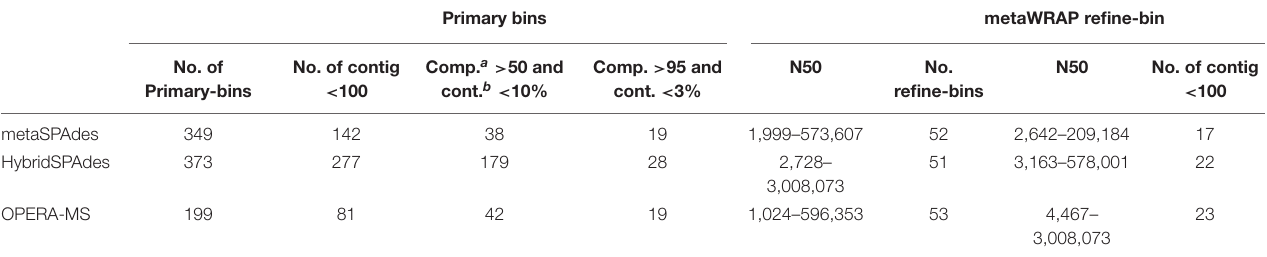
TABLE 2 | Summary of primary bins and refined bins